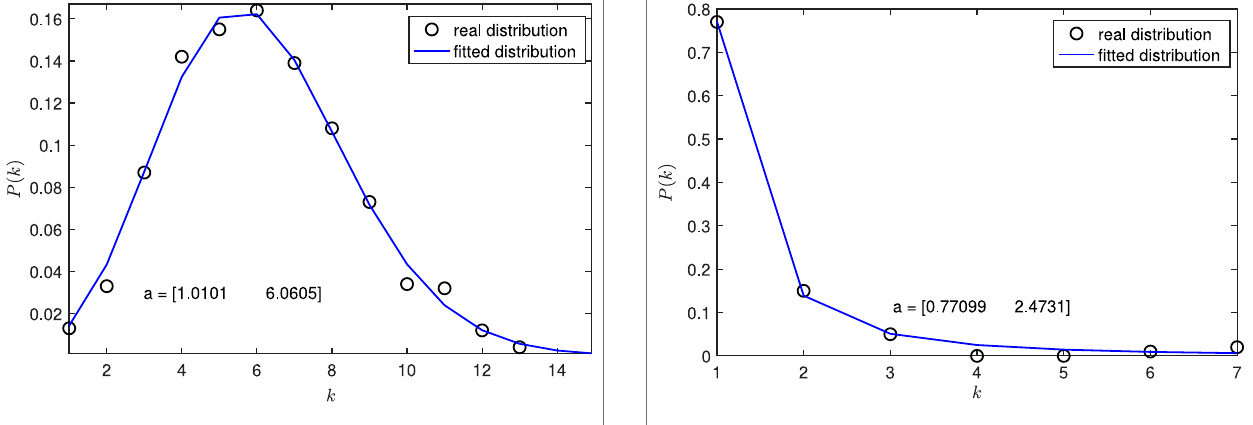
FIGURE 6 | Degree distribution of a randomly generated scale-free network ( n (cid:2) 100, λ (cid:2) 2.4, k min (cid:2) 1, k min (cid:2) 10). The function P ( k ) (cid:2) a 1 k − a 2 is is used for curve fi tting. k ! used for curve fi